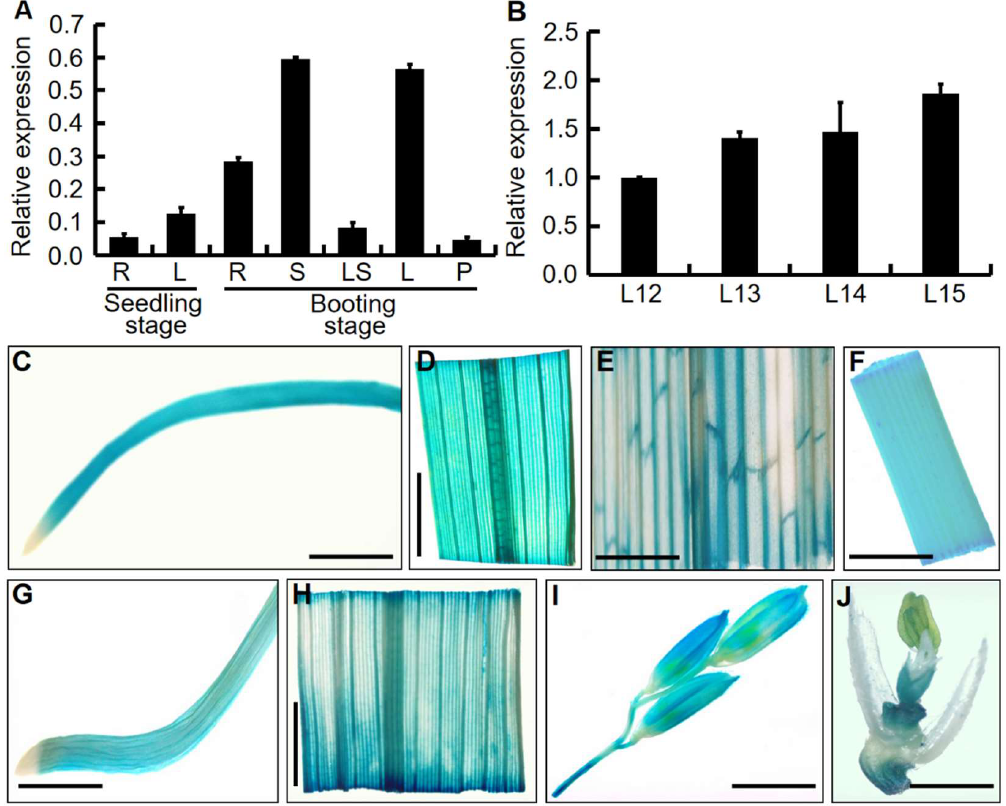
Figure 6. Expression pattern analysis of OsDRB2 . ( A ) The spatiotemporal expression of OsDRB2 in root (R), leaf blade (L), stem (S), leaf sheath (LS), and young panicle (P) of the wild type at seedling stage (three-leaf stage) and booting stage. ( B ) Expression levels of OsDRB2 in leaf blades of the wild type at different developmental stages. L12, L13, L14, and L15 indicate the 12th, 13th, 14th, and 15th full-expanded leaves from the stem base, respectively (the 15th leaf was flag leaf). The expression level of OsDRB2 in the 12th leaf was set to 1.0, and those at the other leaves were calculated accordingly. Error bars represent the standard deviations (SDs) of three independent experiments in ( A , B ). ( C – J ) Histochemical analysis of OsDRB2 expression by GUS staining. OsDRB2 was expressed in root and leaf blade at seedling stage ( C , D ), leaf sheath I, stem ( F ), root ( G ), leaf blade ( H ), young panicles and branches ( I ), and stamens and pistils ( J ) at booting stage. Black bar = 5 mm.